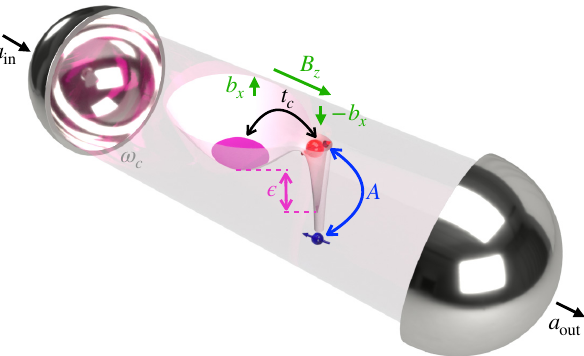
FIG. 1. QD-donor system coupled to a single-mode microwave cavity. The cavity transmission A c = (cid:2) a out (cid:3) / (cid:2) a in (cid:3) reveals the nuclear spin state. The QD-donor energy levels are detuned by an amount (cid:2) and hybridized by tunnel coupling t c . The spin of the confined electron is subject to a homogeneous magnetic field B z and a gradient field b x perpendicular to B z , while the electron charge is coupled to a single mode ( ω c ) of a microwave cavity with electric-dipole coupling strength g c . The electron interacts with the nuclear spin of the implanted donor via the hyperfine interaction A